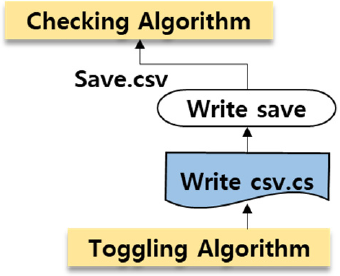
Figure 15. Algorithm for development of report function.